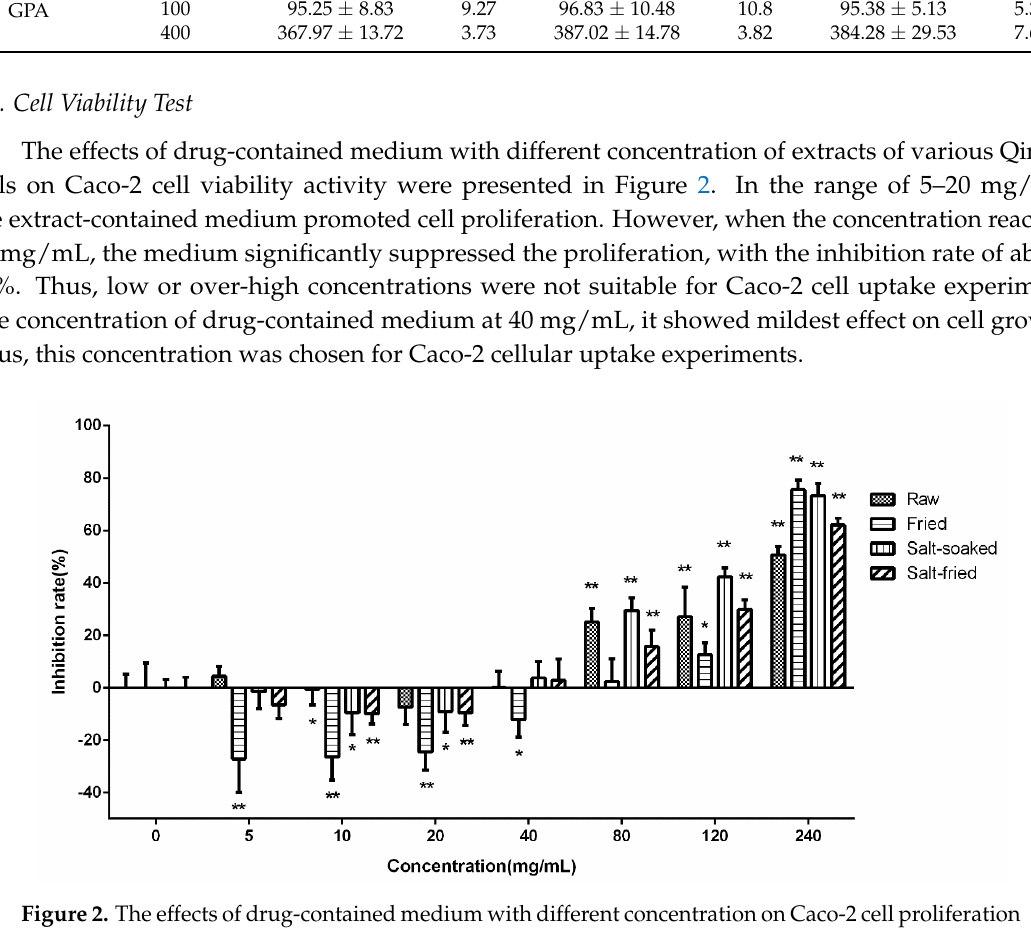
Table 3. Stability of four analytes in cell lysate.